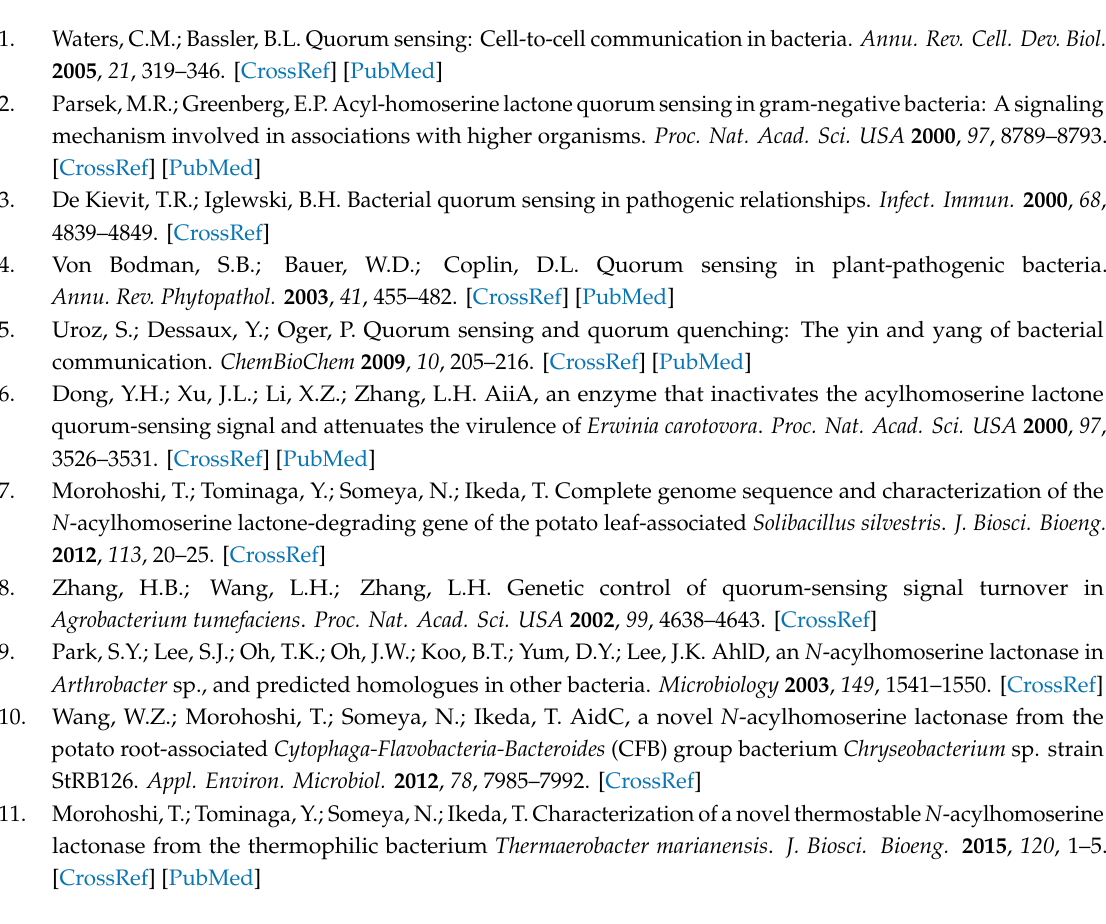
Figure S1: Phylogenetic tree based on amino acid sequences of AhlS from CNS strains, Figure S2: Restoration of C10-HSL degraded by E. coli DH5 α harboring ahlS from CNS strains, Figure S3: SDS-PAGE analysis of